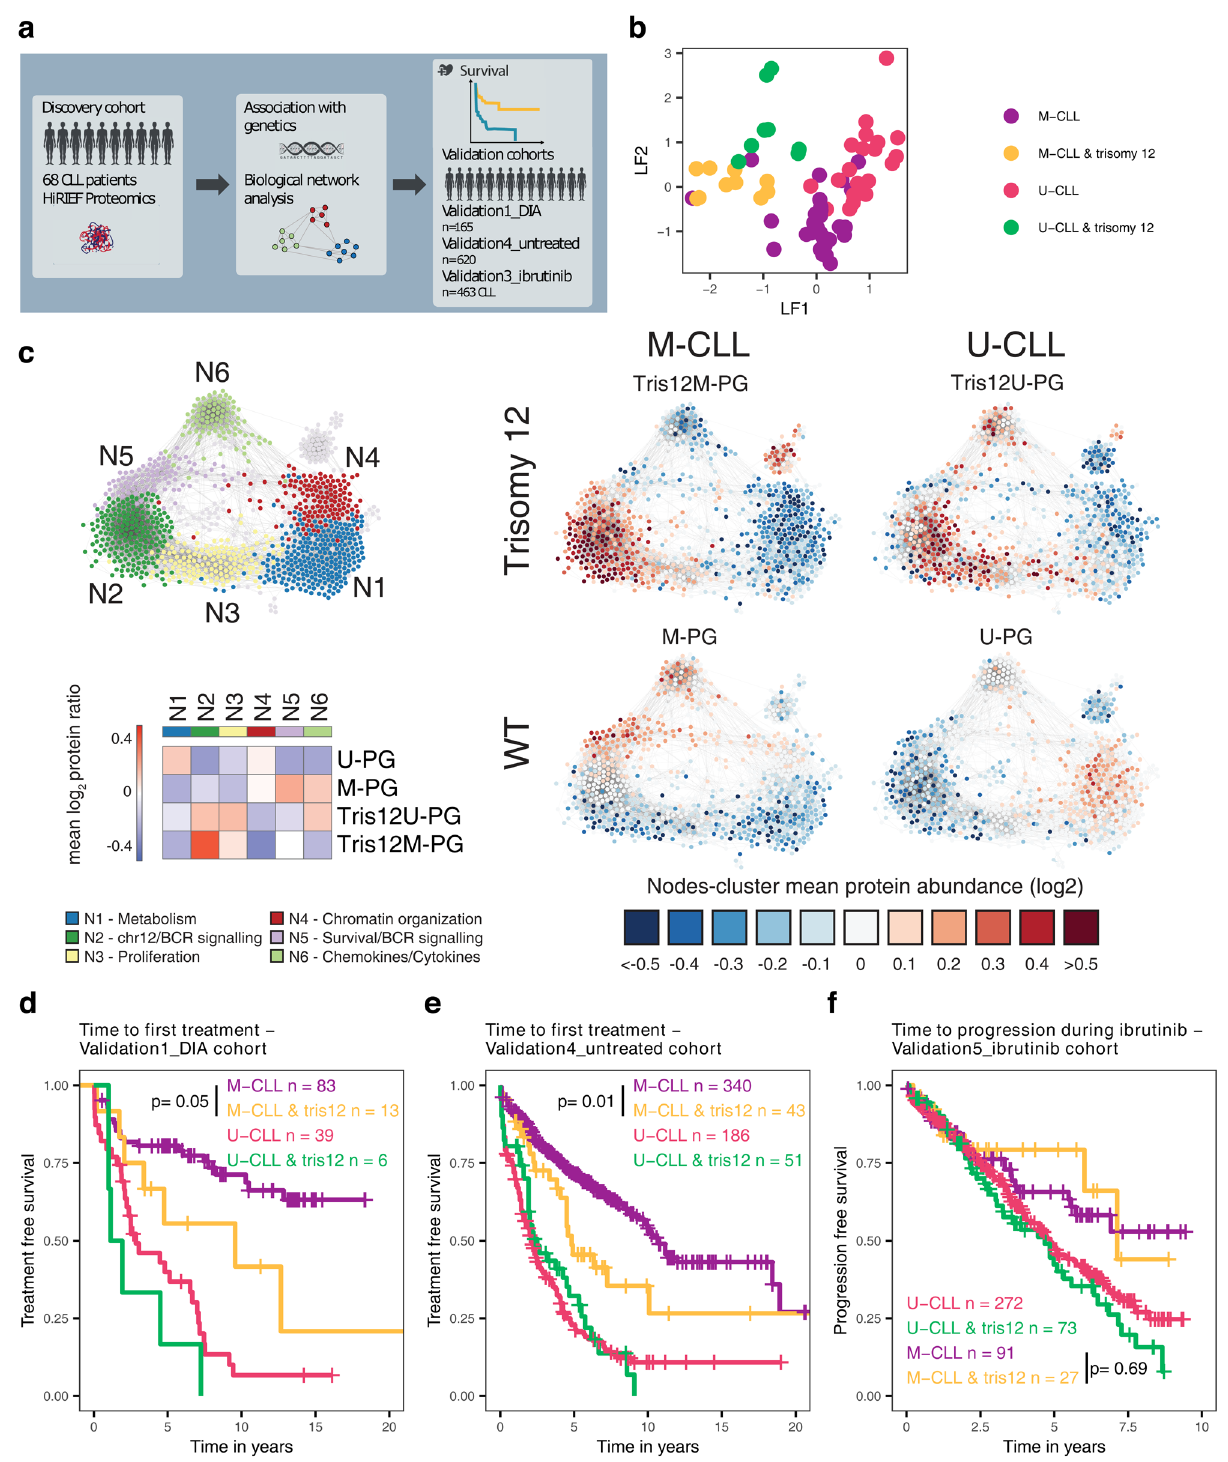
Fig.7 | Relevanceofthecelloforigin forthein fl uenceof trisomy12ontheCLL proteomeandclinicaloutcome.a ValidationstrategyforTris12M-PG,Tris12U-PG, M-PG,andU-PG. b PlotofloadingsonLF1andLF2ofindividualpatients.LF1andLF2 couldclassifypatientsinto4groupsaccordingtoIGHVstatusandtrisomy12. c CLL proteincorrelationnetworkanalysisofHiRIEFdatasetbasedon1047high-variance proteins. Protein groups were de fi ned and color-coded based on modularity clus- tering (N1-N6) and enrichments detailed in Supplementary Fig. 9. A Heatmap of log2 mean relative protein abundances for all PGs for each modularity cluster (N1- N6)and node-clustermeanproteinabundances forTris12M-PG, Tris12U-PG, M-PG, and U-PG are shown. d Time to fi rst treatment of patients from Validation1_DIA cohort, strati fi ed into groups by IGHV mutation status and trisomy 12 (tris12).